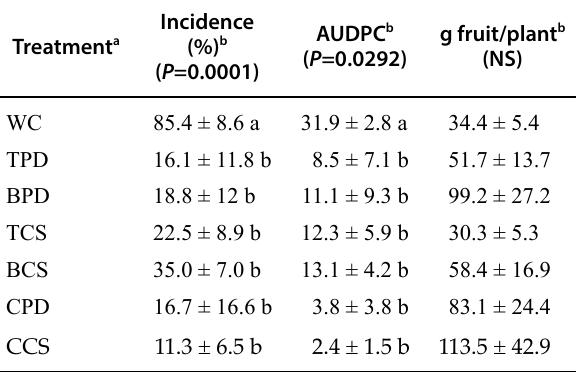
Table 5. Means of disease incidence, AUDPC and weights of fruit after application of different biological and chemi - cal treatments for control of crown and root rot caused by Fusarium solani in ‘Camarosa’ strawberry plants under field